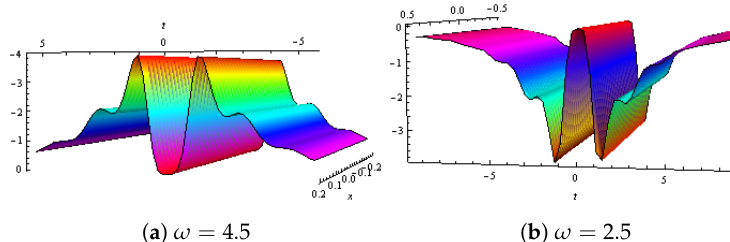
Figure 24. ( a , b ) show 3D plots.